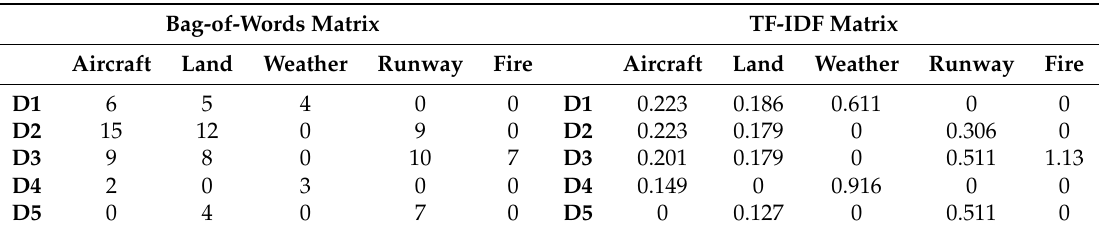
Table 3. Notional Bag-of-Words and term-frequency inverse-document-frequency (TF-IDF) Matrices.